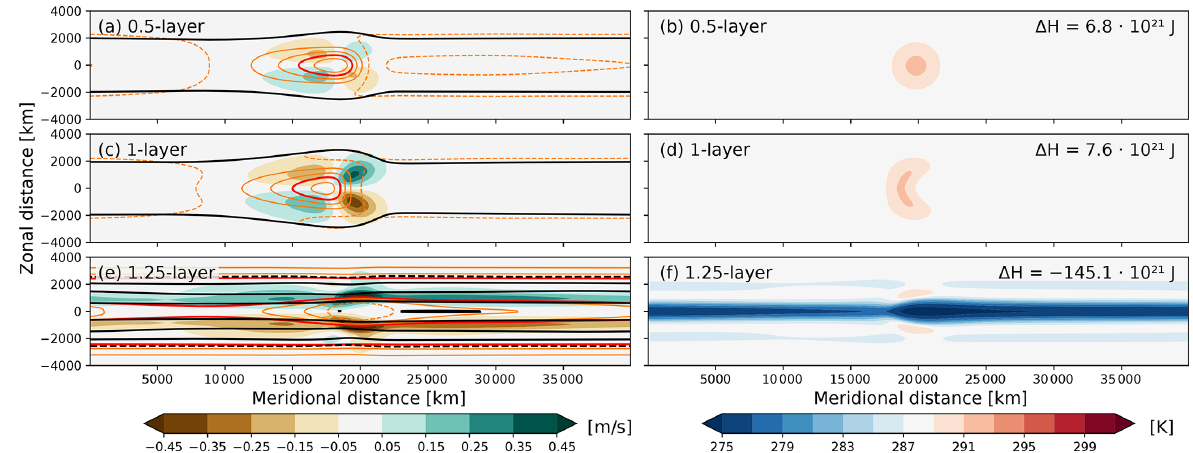
Figure 12. Near-stationary wave response to a coupled equatorial SST anomaly on a β plane for full PE after 60d of lead time. From top to bottom, the rows show the development of (a, b) the 0.5-layer model, (c, d) the 1-layer model, and (e, f) the 1.25-layer model. The panel setup for the left column is the same as in Fig. 11, but to accommodate the much larger sea level pressure anomalies in (e) , black contours are shown at − 1 . 5 through 1.5hPa in steps of 1hPa and at 5 and 10hPa, and zonal wind contours are omitted beyond 2.5ms − 1 . The maximum zonal wind anomaly on either side of the Equator is about 7ms − 1 . The right column shows ocean mixed-layer temperatures in Kelvin, with the numbers in the top-right corners indicating the domain-integral mixed-layer heat anomaly relative to